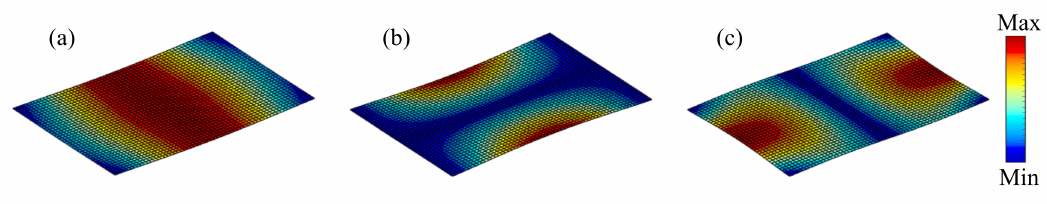
Figure 20. The first three eigenmodes of the plate with four corners fixed. ( a ) The first eigenmode at 64 Hz. ( b ) The second eigenmode at 137 Hz. ( c ) The third eigenmode at 171